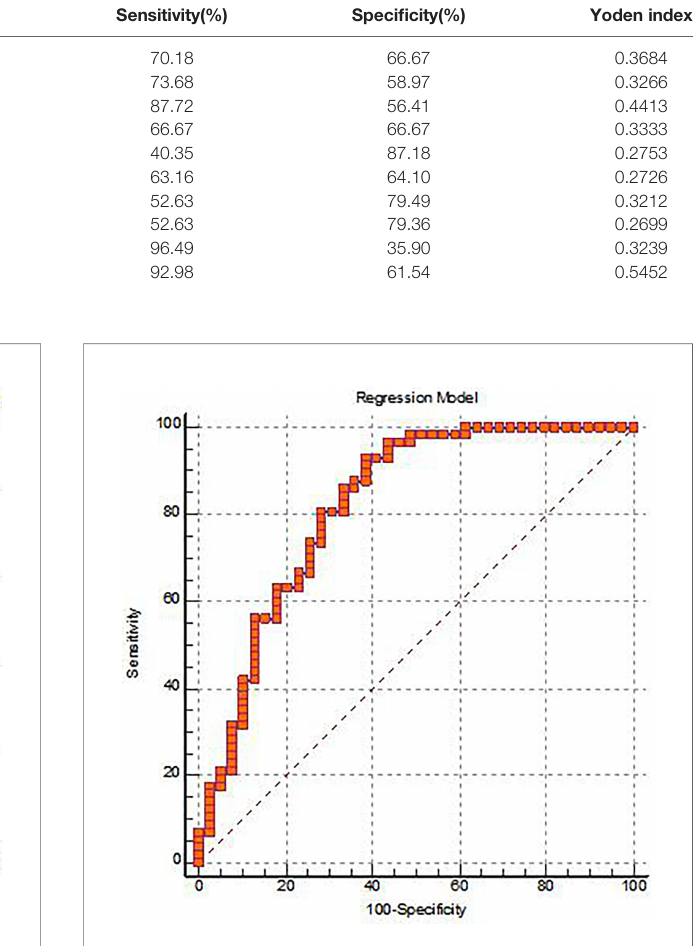
FIGURE 3 | The ROC analysis for the TA parameters of the EMVI positive group and the EMVI negative group. FIGURE 4 | The ROC analysis for the Logistic regression prediction model of the EMVI positive group and the EMVI negative group.